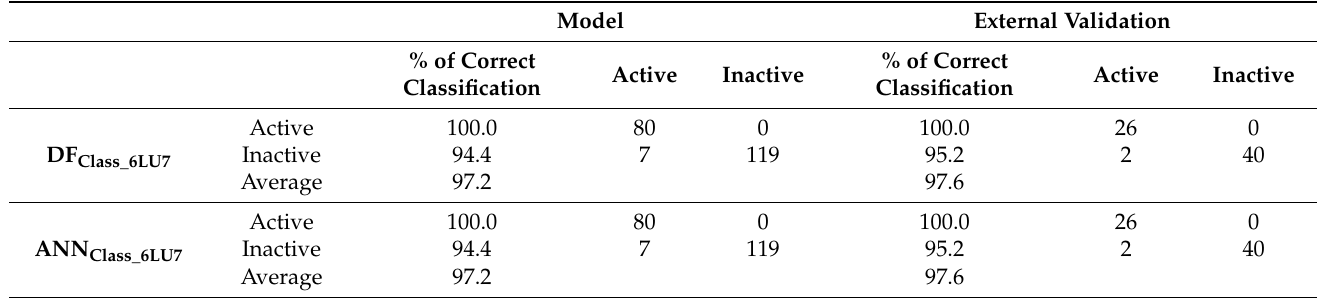
Table 2. Classification matrices for classification models and external validation.